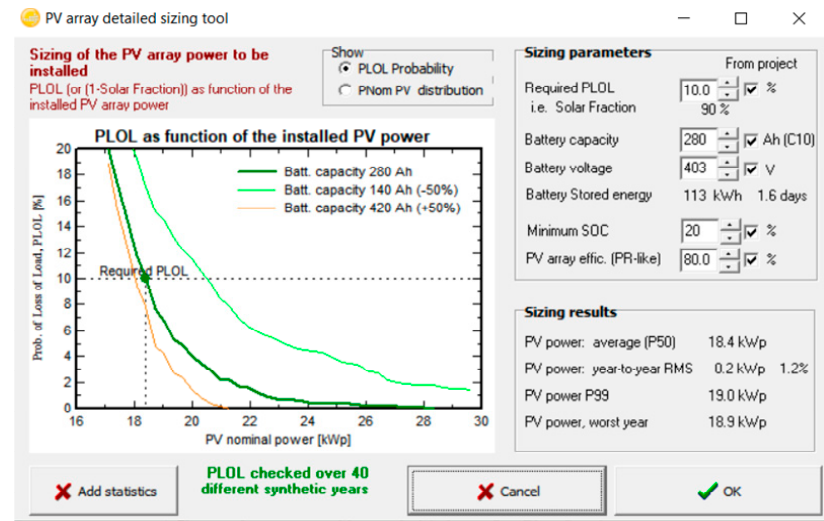
Figure 5. Probability of loss-of-load (PLOL) sizing tool. Table 2. Energy balance of the system.